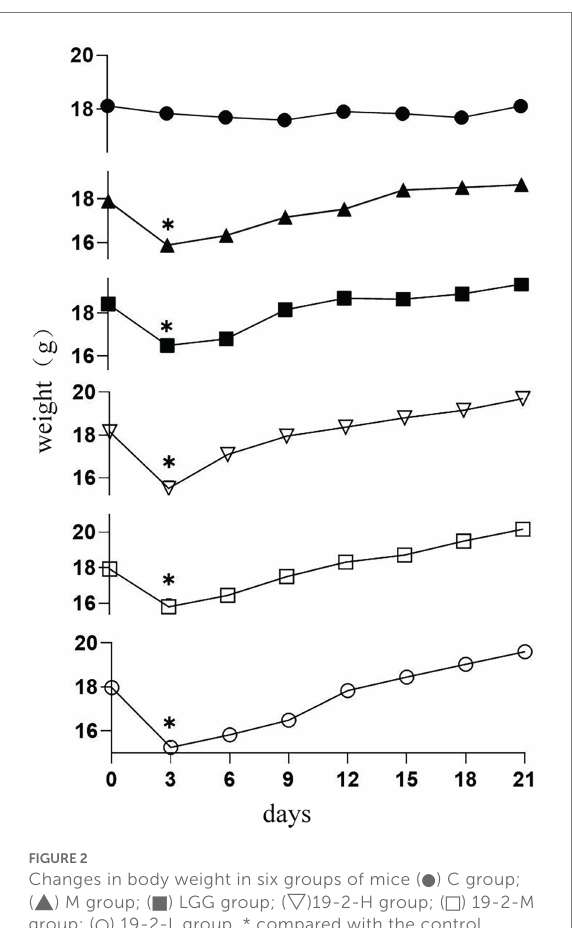
FIGURE 2 Changes in body weight in six groups of mice ( ● ) C group; ( ▲ ) M group; ( ■ ) LGG group; ( ▽ )19-2-H group; ( □ ) 19-2-M group; ( ○ ) 19-2-L group. * compared with the control group, p <